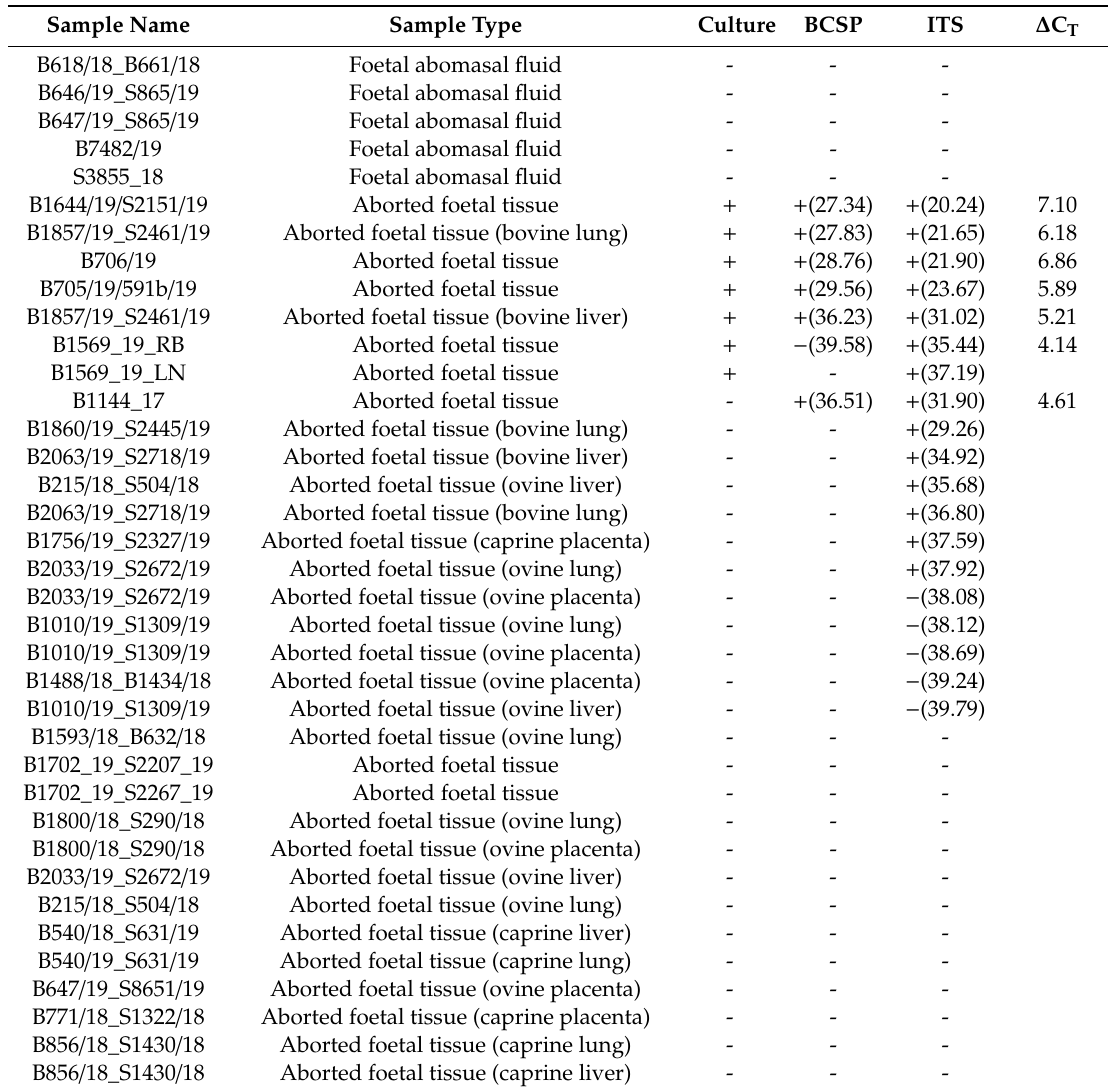
Table 7. Fifty-six aborted foetal samples submitted to DVTD for Brucella spp. testing and